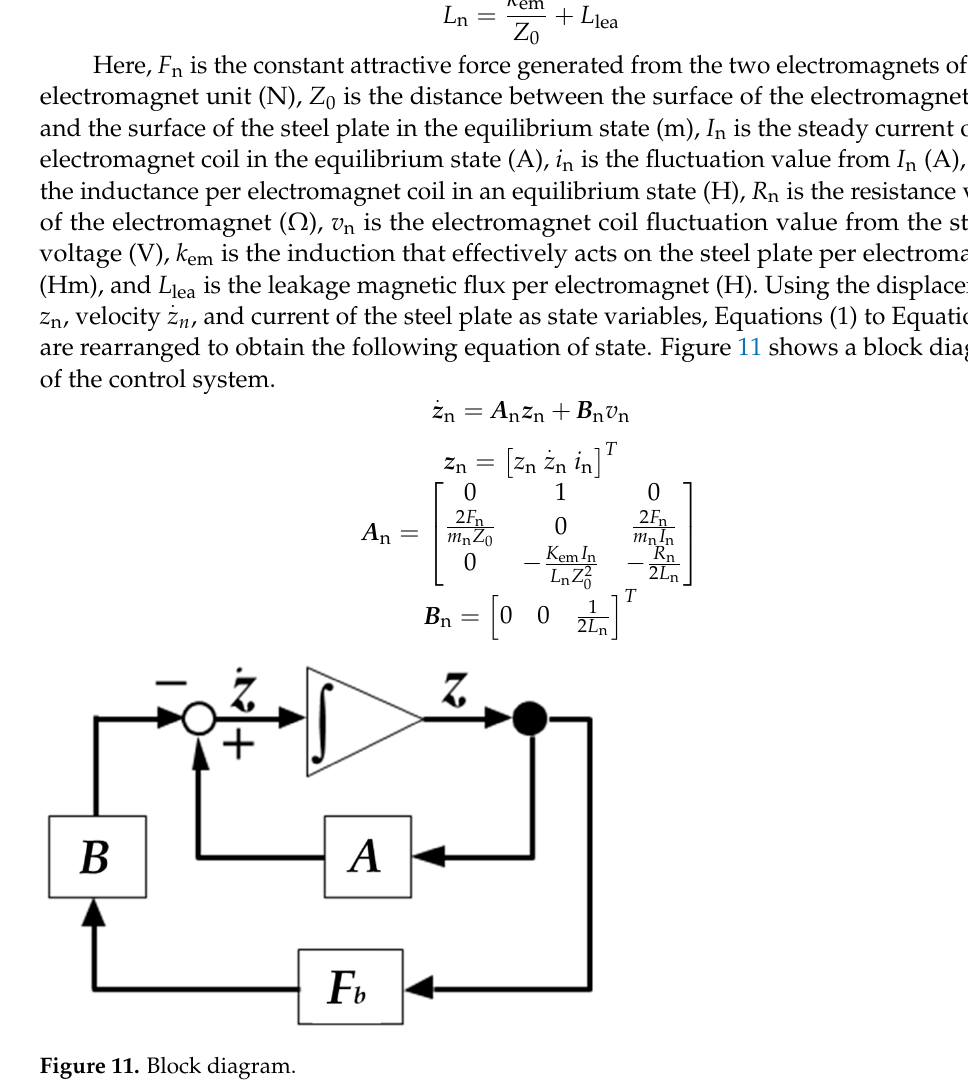
Figure 11. Block diagram.